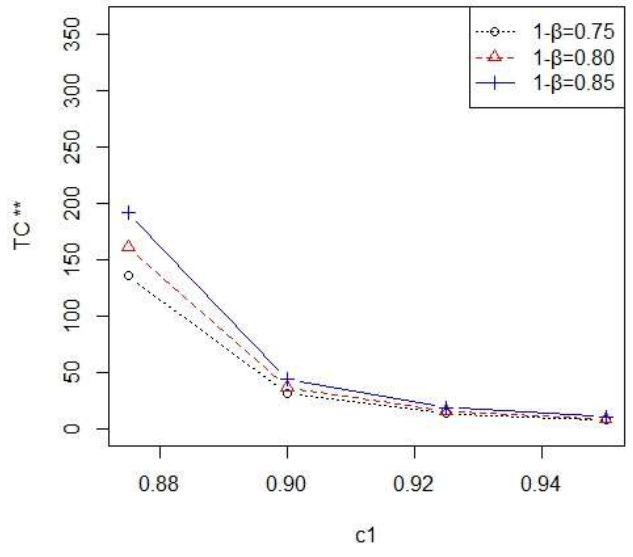
Figure 8. Minimum total cost curve for 1 − β = 0.75, 0.80, 0.85 at α = 0.1 and p = 0.05.